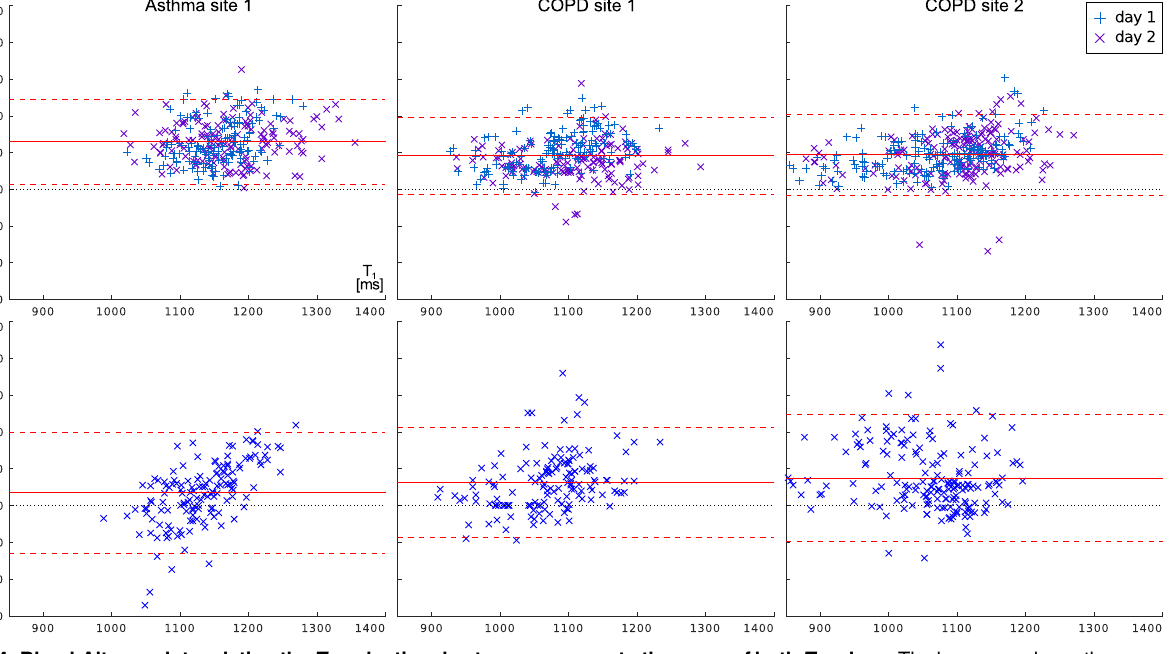
Fig 4. Bland-Altman plots relating the T 1 -reduction due to pure oxygen to the mean of both T 1 values. The lower row shows the reproducibility of T 1 under hyperoxicconditions on both days, analogousto Fig 3.